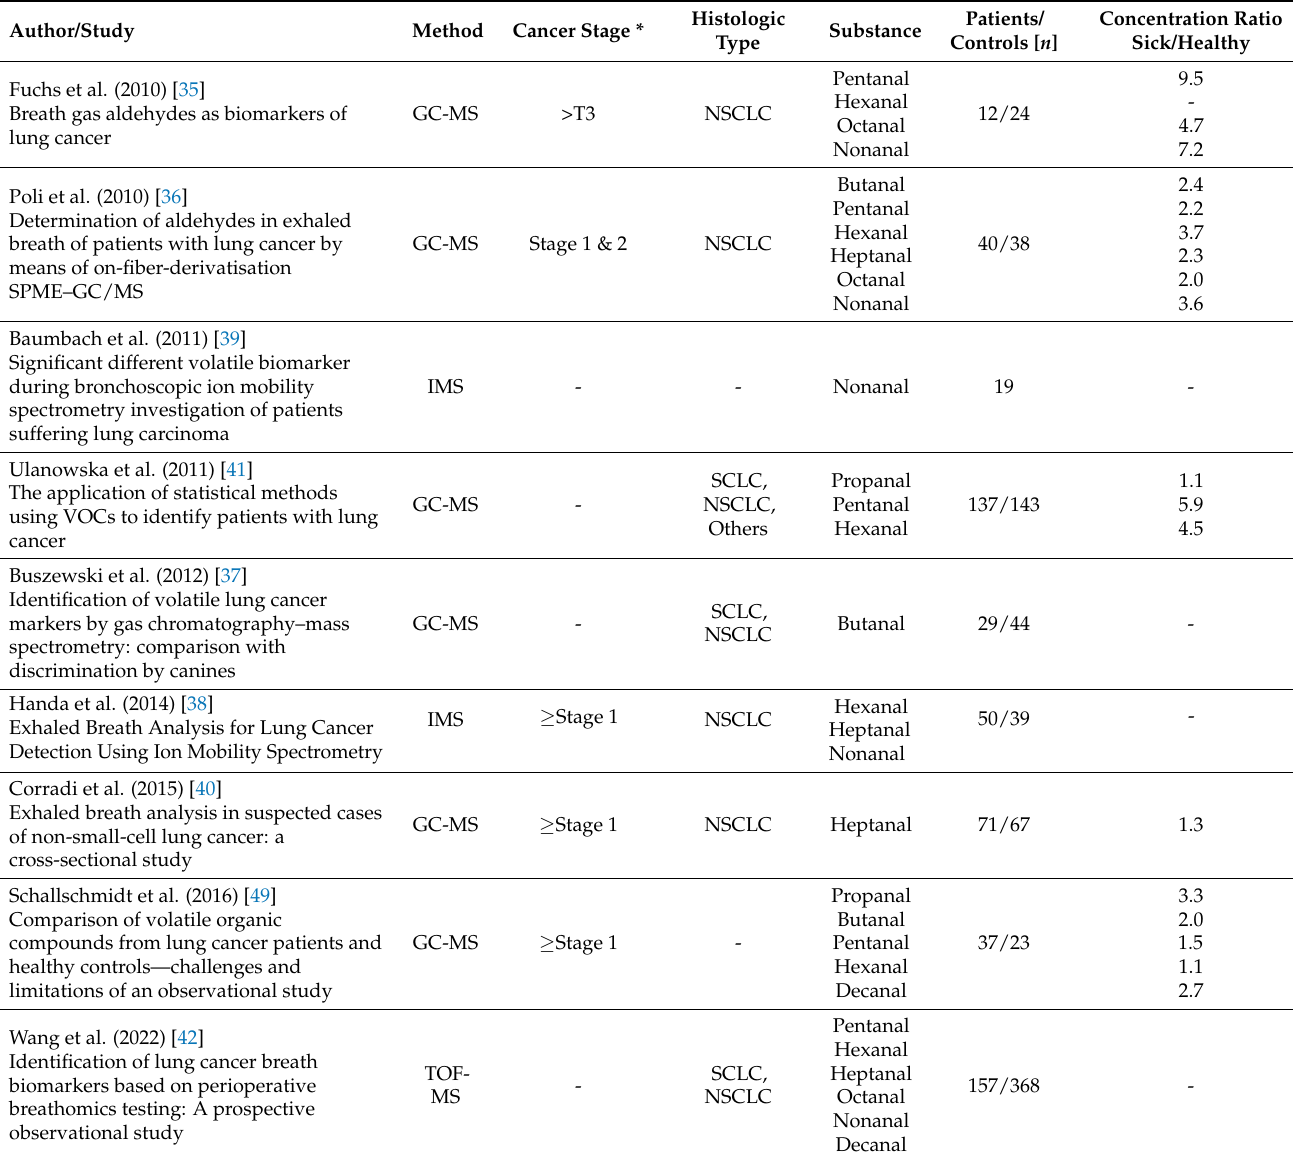
Table 2. Aldehydes as biomarkers of lung